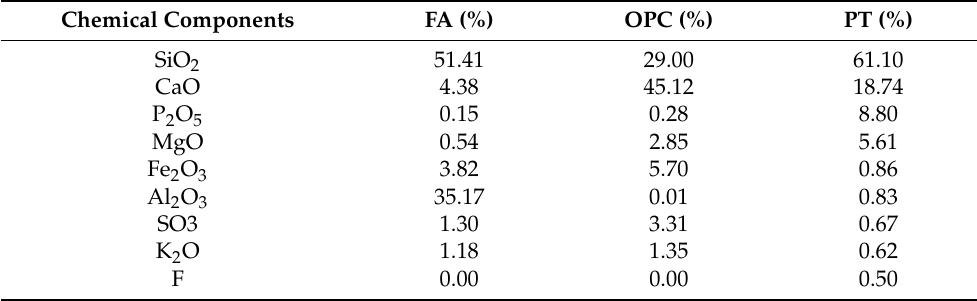
Figure 1. Particle size distribution of PT. Table 1. Main chemical components of FA, OPC, and